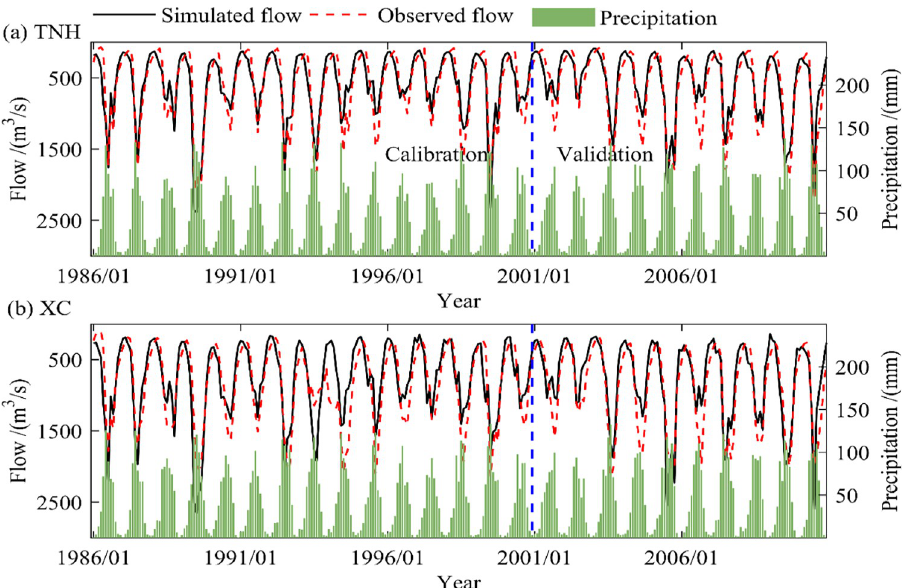
Fig 7. Measured and simulated runoff during the calibration and validation